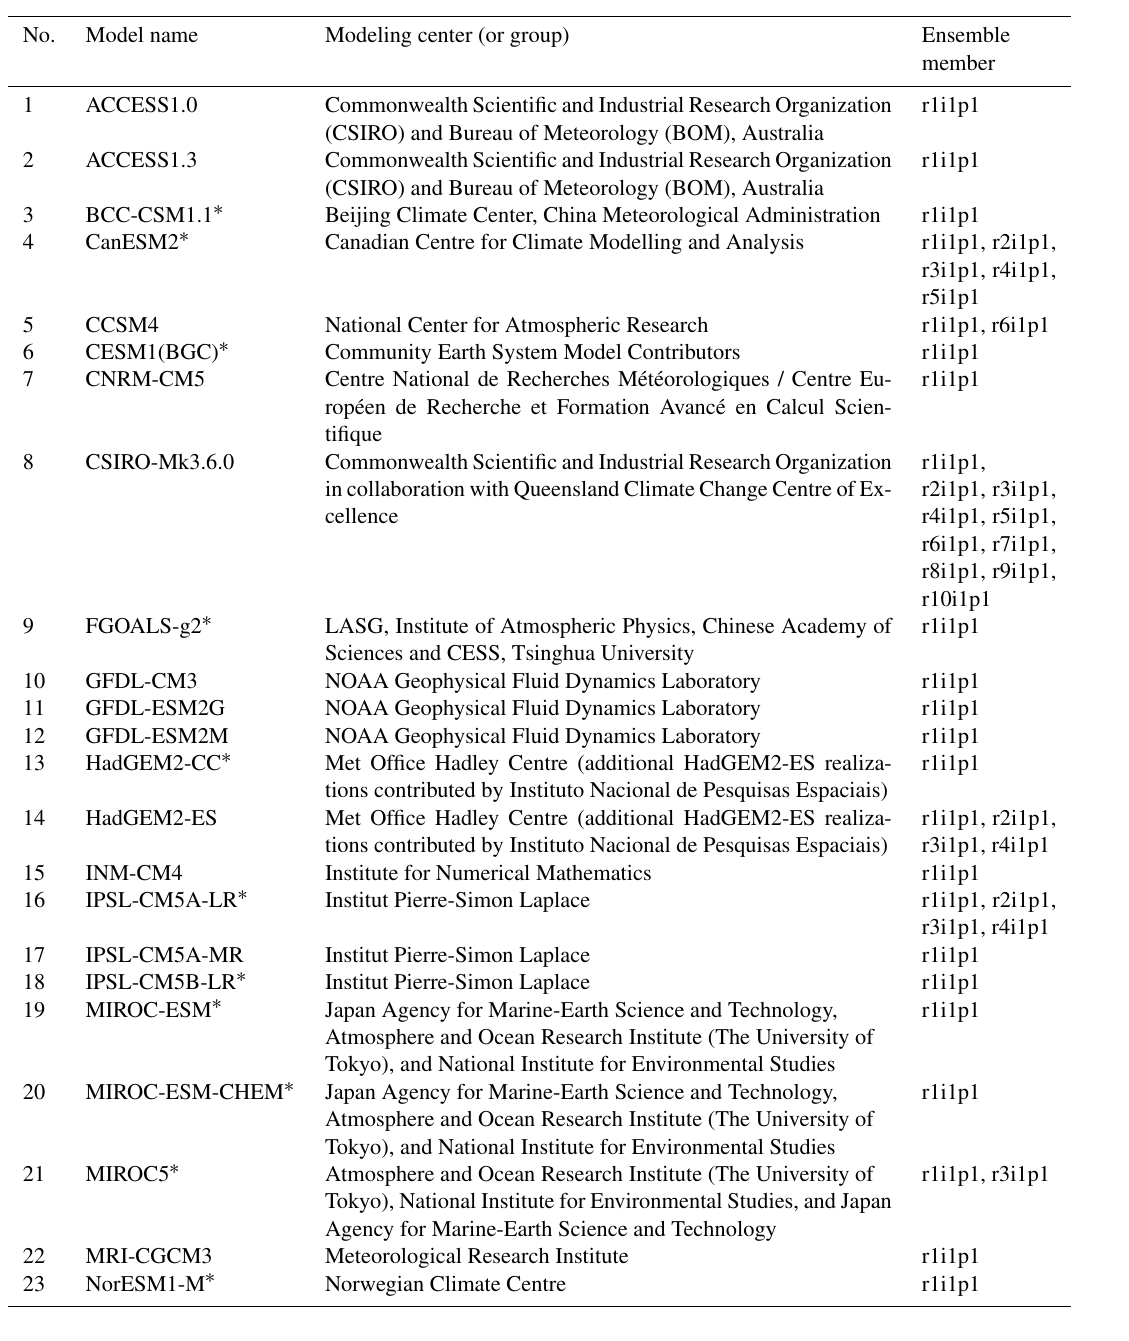
Table A1. Overview of the 23 CMIP5 models. Models marked with ∗ are within the constrained ensemble. No. Model name Modeling center (or group) Ensemble